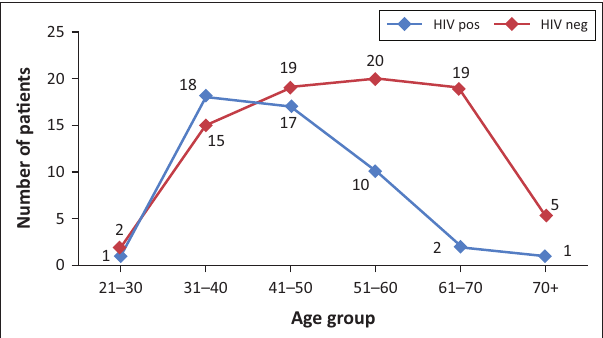
FIGURE 2: Summary of the age distribution of human immunodeficiency virus status in breast cancer patients.